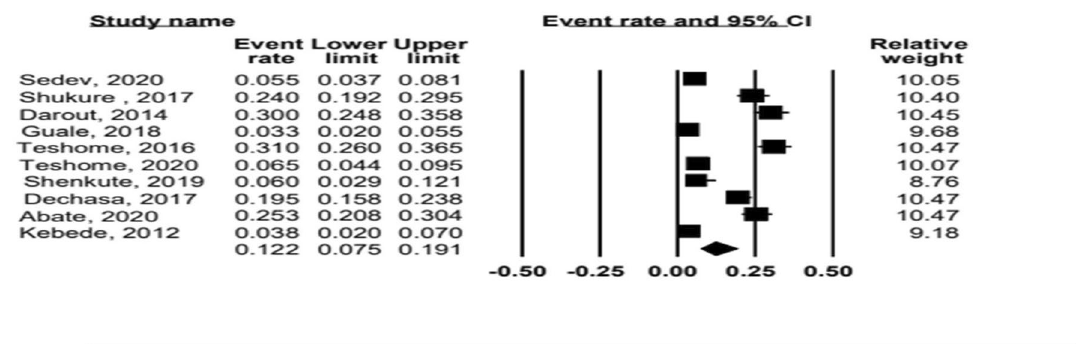
Figure 2. Forest plot of pooled prevalence/level/of tooth brushing